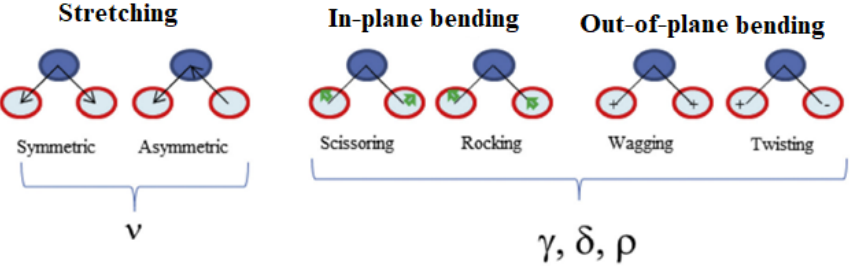
Figure 2. Vibration modes in FTIR spectroscopy “(From Ref. [21] and used under Creative Commons CC-BY license.)”.